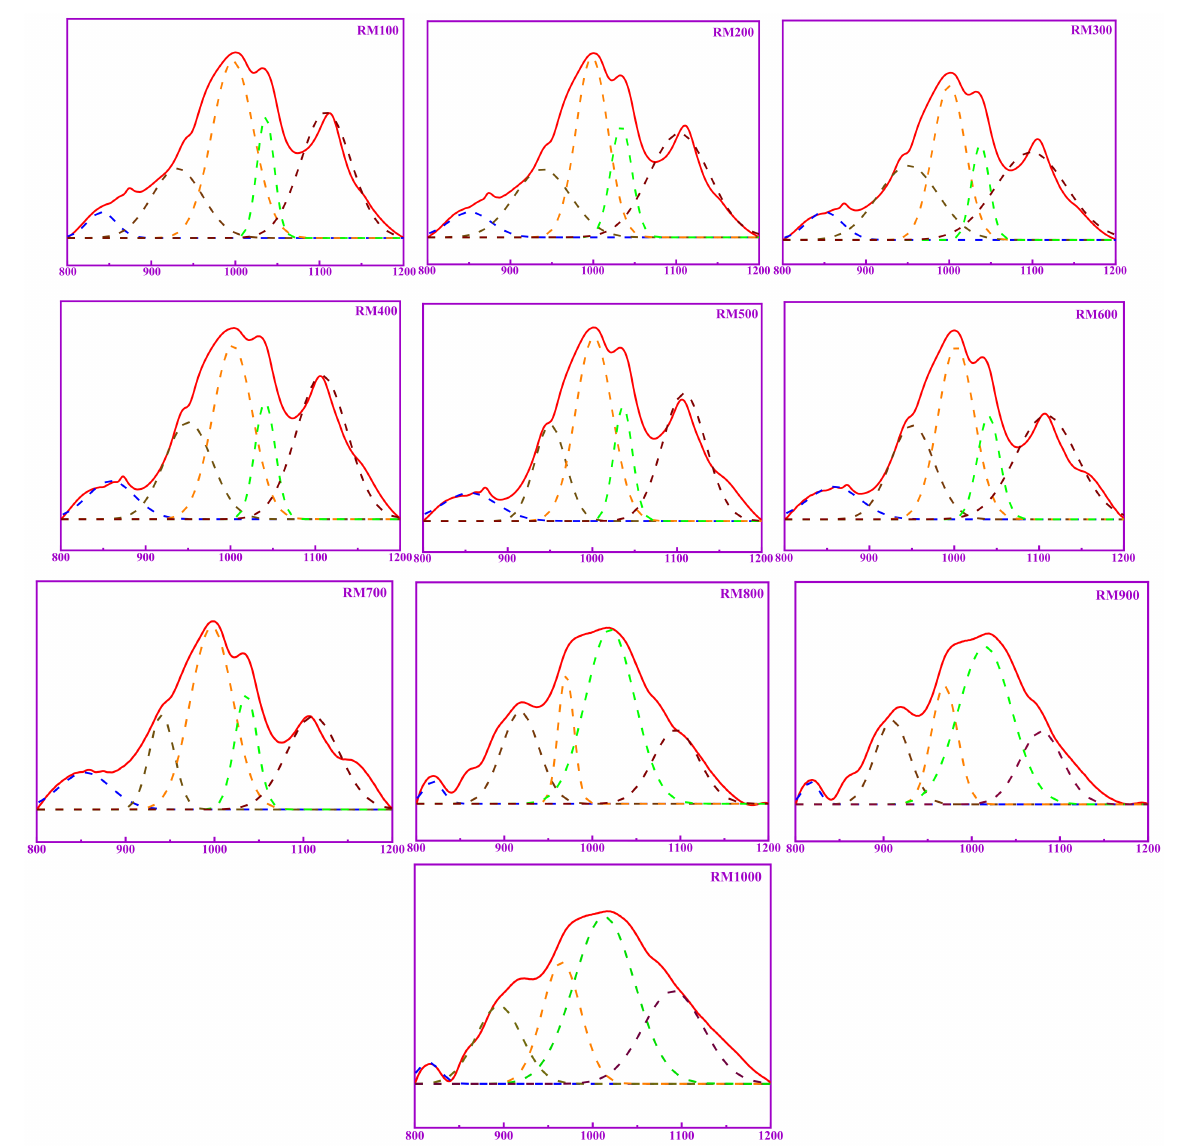
Figure 7. The peaks in the range of 800–1200 cm − 1 of calcined RM at different temperatures. Table 4. The relevant parameters of the peaks of calcined RM at different